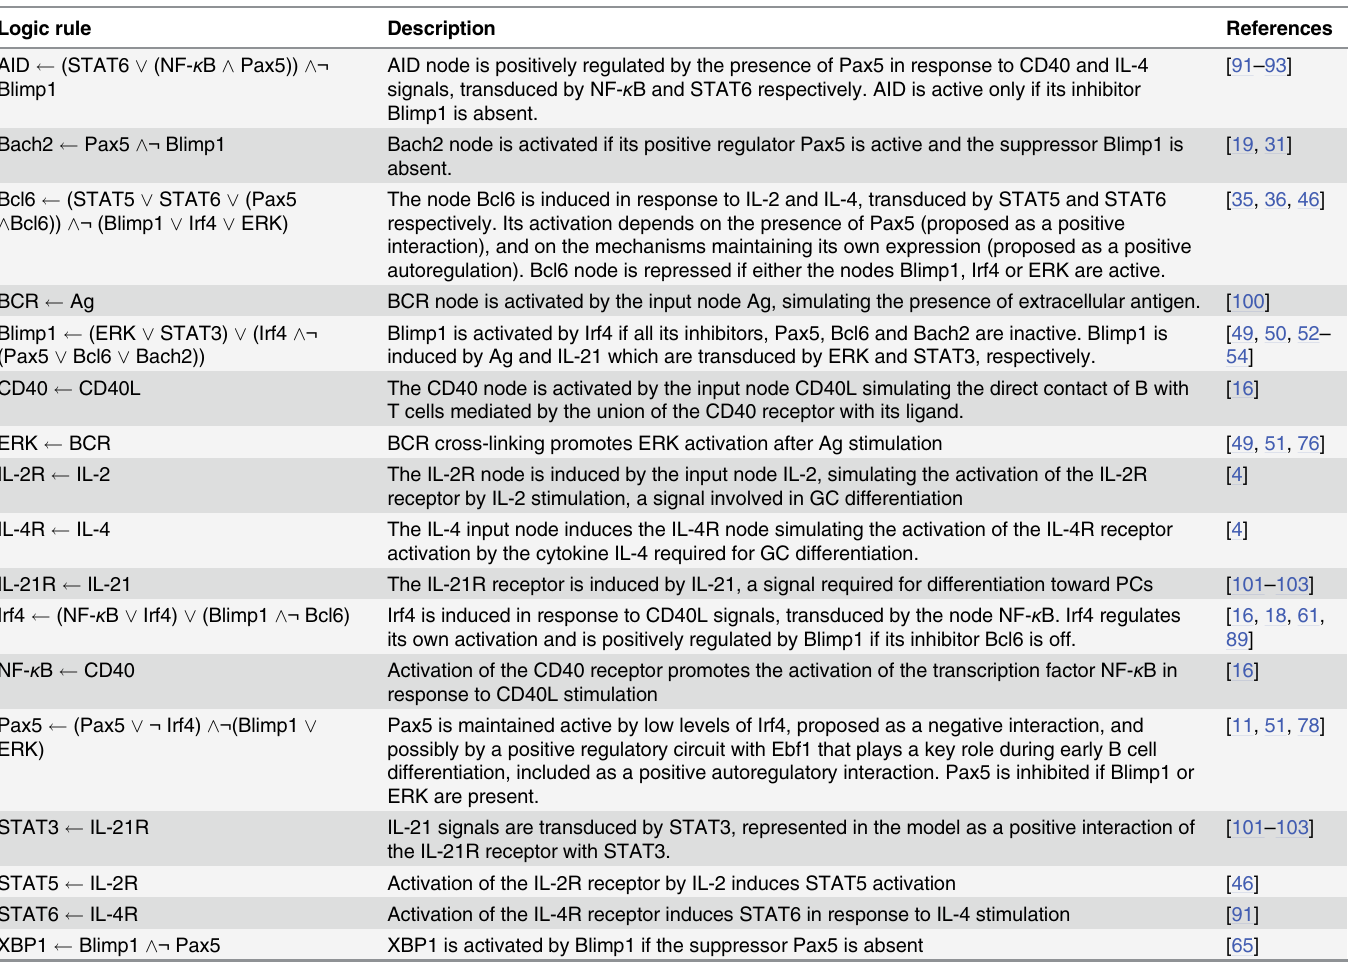
Table 6. Logical rules. The set of Boolean rules defining the regulatory network of the terminal differentiation of B cells. Logic rule